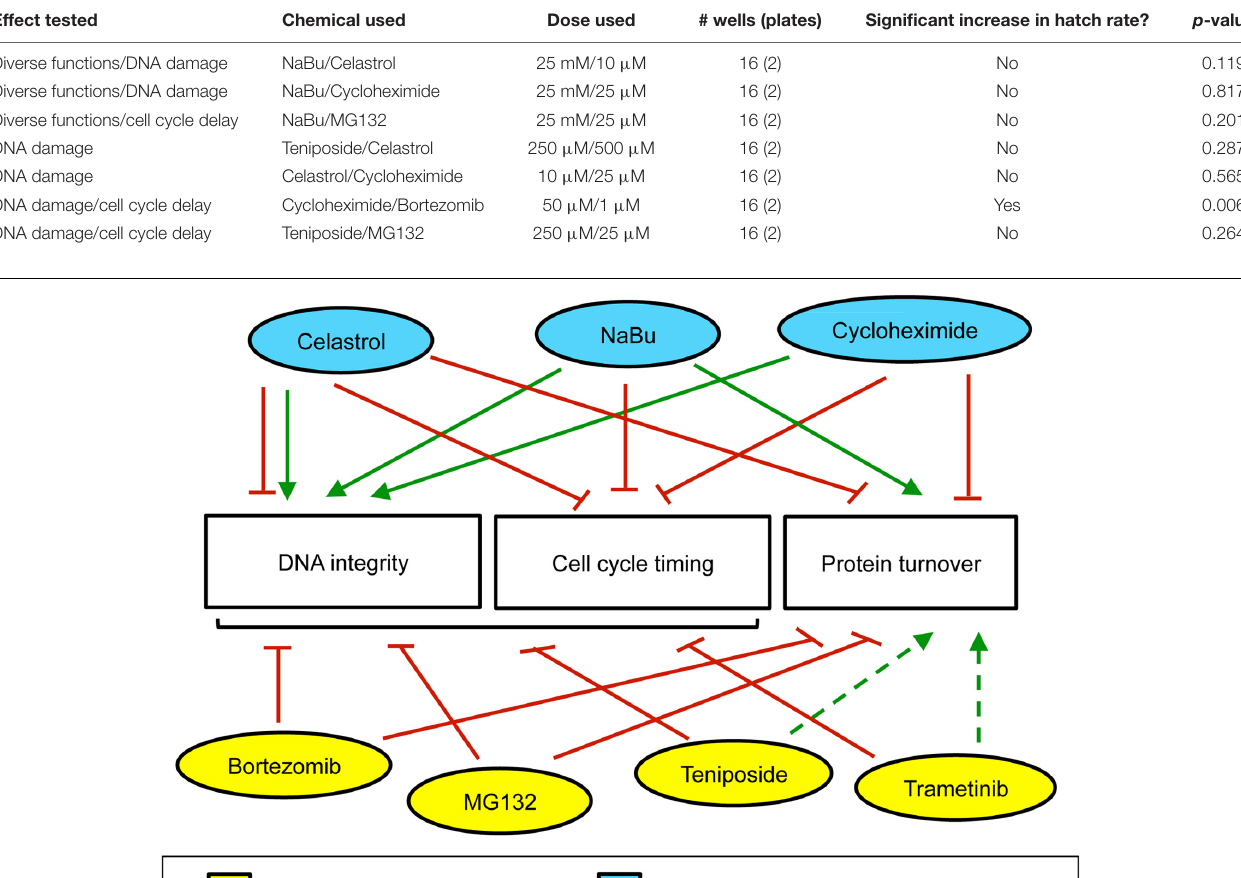
TABLE 5 | Impact of chemical combinations on CI egg hatch rates for w Ri-infected D. simulans.